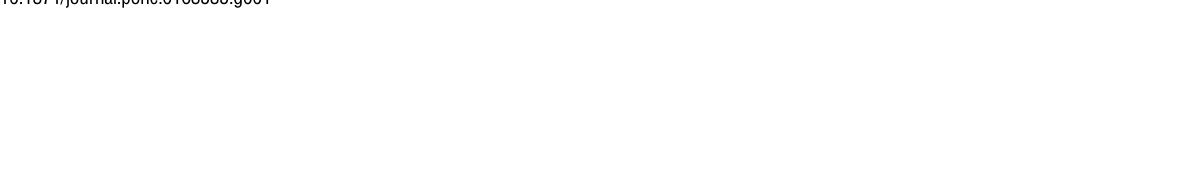
PLOS ONE | DOI:10.1371/journal.pone.0163535 October 3,